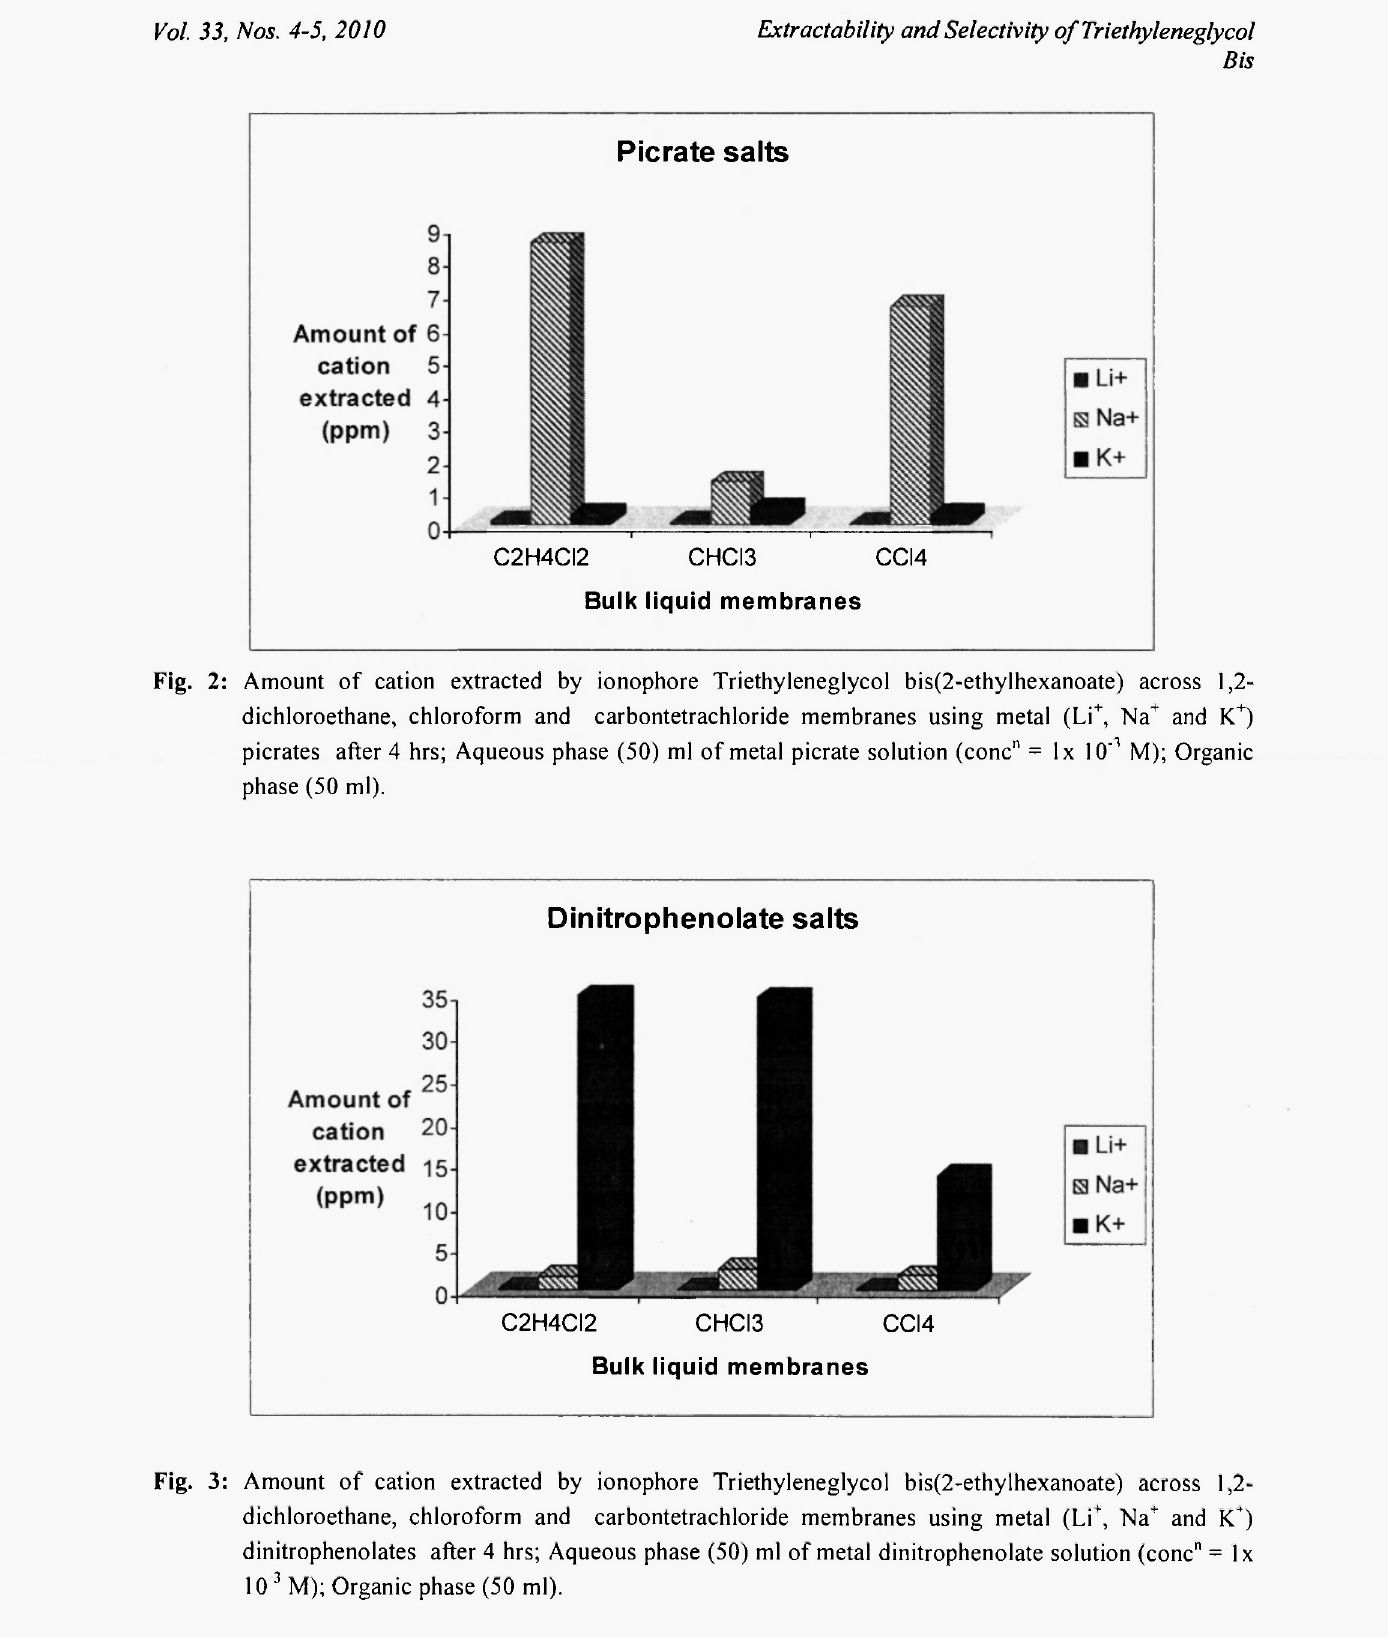
Fig. 3: Amount of cation extracted by ionophore Triethyleneglycol bis(2-ethylhexanoate) across 1,2- dichloroethane, chloroform and carbontetrachloride membranes using metal (Li + , Na + and K + ) dinitrophenolates after 4 hrs; Aqueous phase (50) ml of metal dinitrophenolate solution (conc" = 1 χ 10 3 M); Organic phase (50